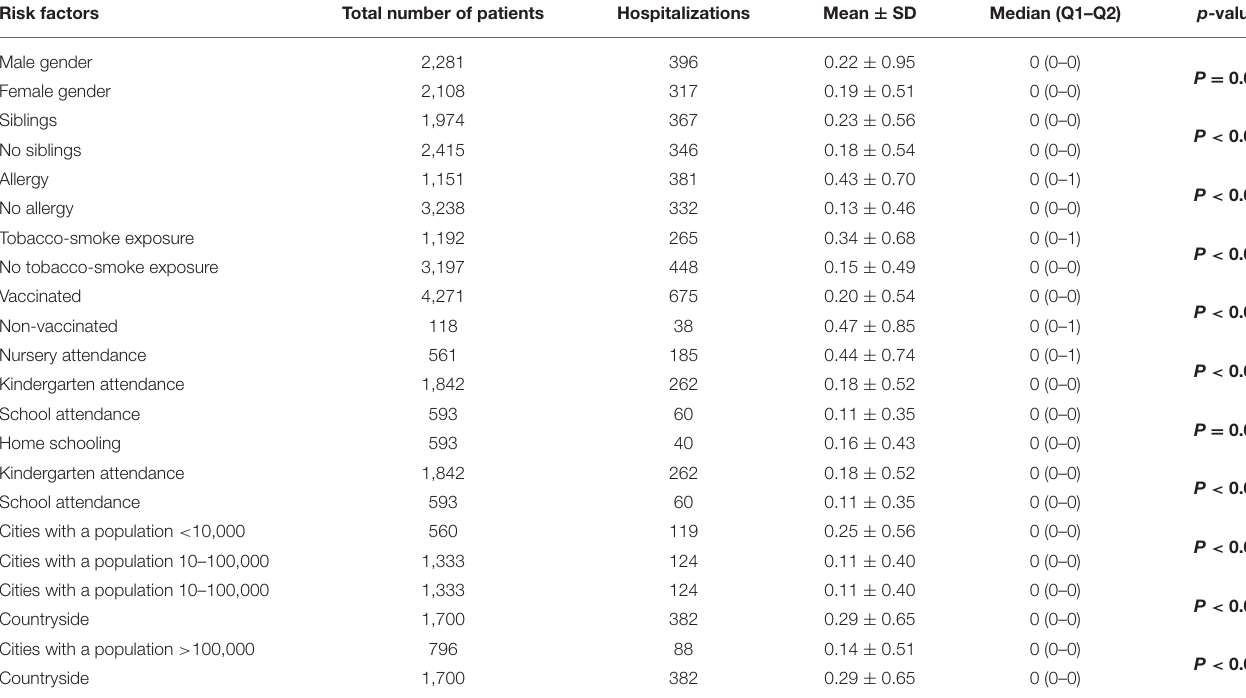
TABLE 3 | Hospitalization rates and selected environmental and clinical factors in the study group ( n =